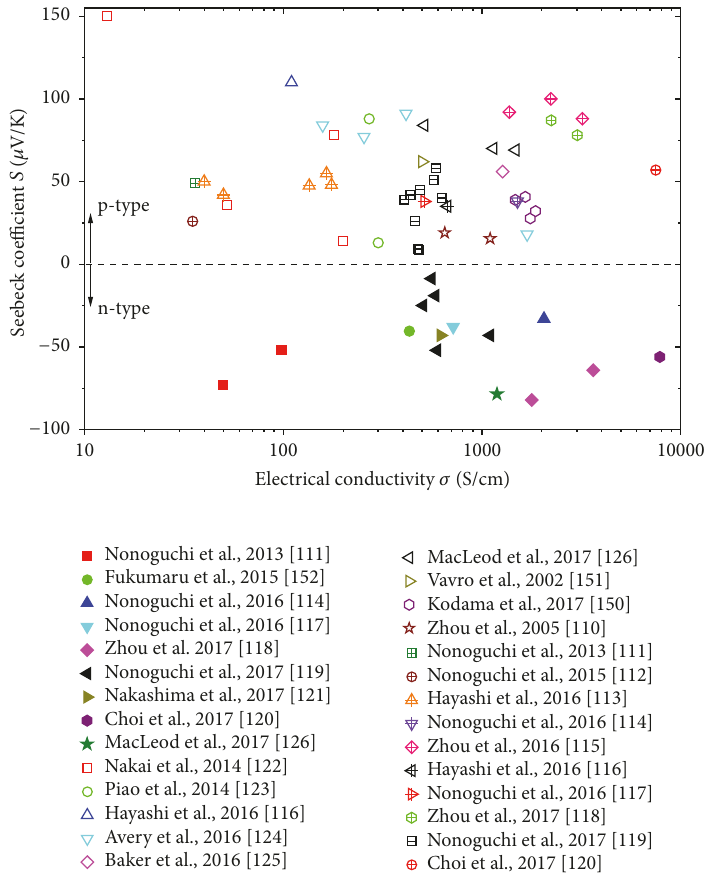
Figure 8: Seebeck coefficient and electrical conductivity of SWCNT-based TE materials measured in previous studies.